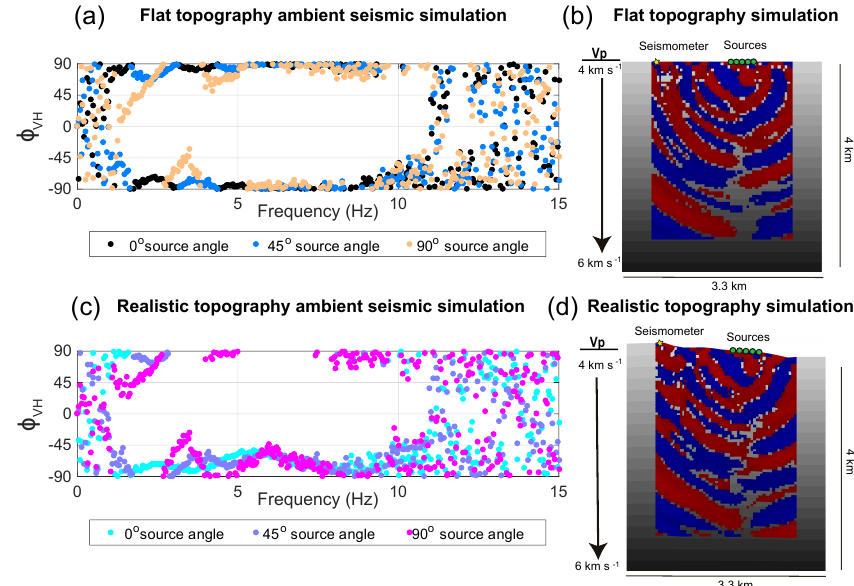
Figure 9. Polarization attributes computed using FDPA of synthetic seismograms computed using SPECFEM2D are shown in panels (a) and (c) ; with corresponding simulated topographies. The distributed source of the spillway is approximated by five sources spaced 100m apart with a source frequency of 5–10Hz. Random noise was added to the results of the simulation to approximate background seismic noise. Panels (a) and (b) display the horizontal component seismic wave field during a single time step in each simulation. In the flat topography simulation (a) , the vertical–horizontal phase difference is closer to ± 90 ◦ than in the simulation that includes the realistic hillslope topography (c) . With a vertically incident force (0 ◦ source angle), the phase difference is lowest, while with increasing source angle, the vertical motion becomes less like a classical Rayleigh wave below